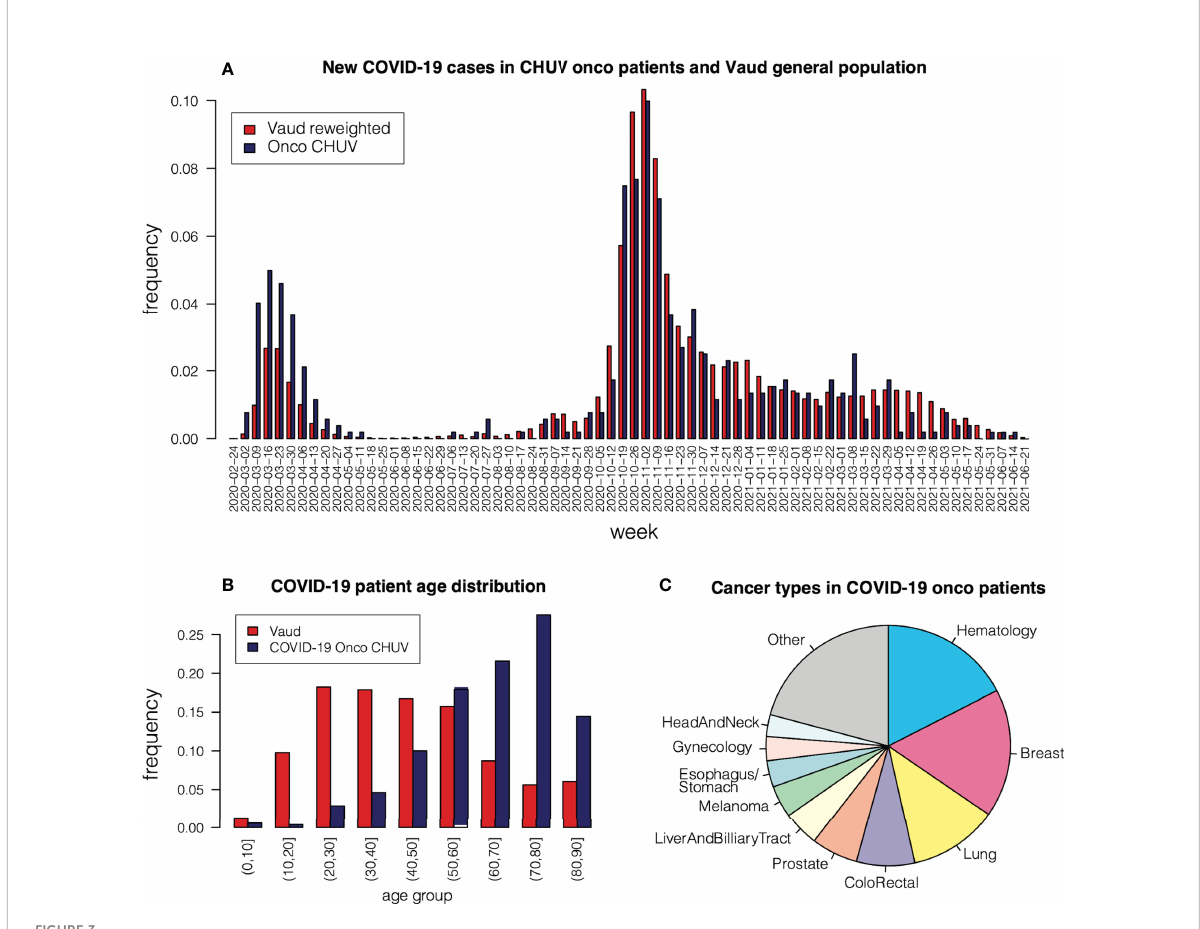
FIGURE 3 (A) Occurrence of COVID-19 cases among CHUV oncological patients, compared to occurrences in the Vaud region re-weighted according to age group. (B) Age distribution in oncological COVID-19 patients at CHUV, compared to the general population in the Vaud region. (C) Cancer type in COVID-19 patients at CHUV.